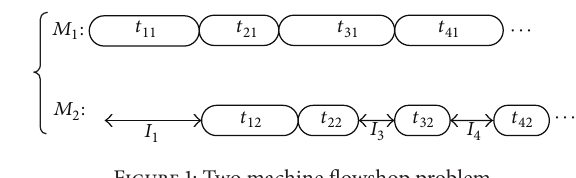
Figure 1: Two machine flowshop problem.